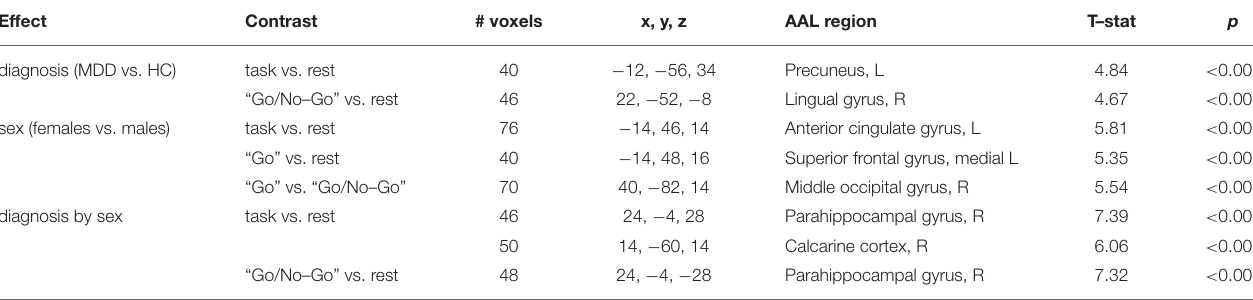
TABLE 2 | Diagnosis and sex modulations on the task-related fMRI activations. Effect Contrast # voxels x, y, z AAL region diagnosis (MDD vs. HC) task vs.